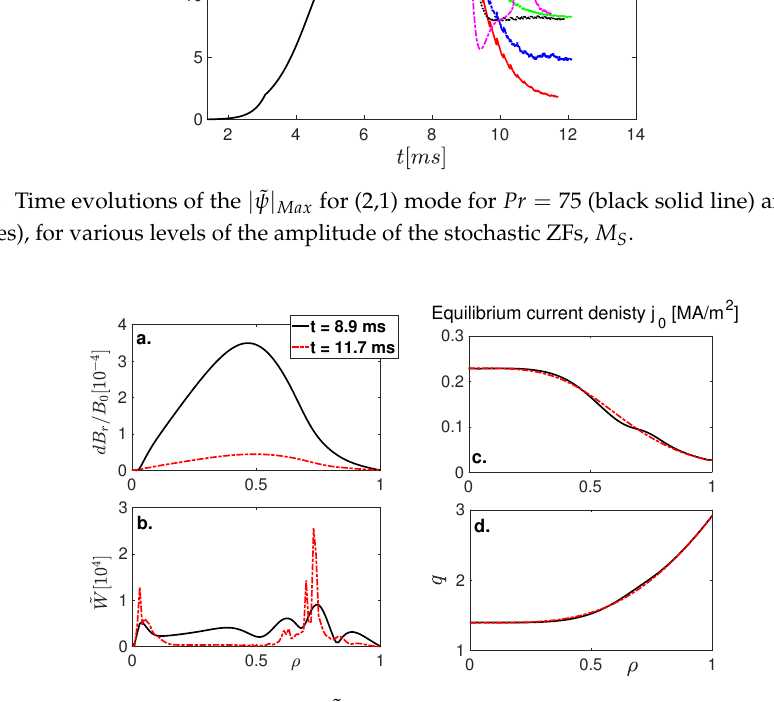
Figure 6. The profiles of the dB r / B 0 ( a ), ˜ W ( b ), equilibrium current density j 0 ( c ), and safety factor q ( d ) for the ( 2,1 ) mode case, at time t = 8.9 ms corresponding to M S = 0 (red solid lines), and t = 11.7 ms corresponding to M S = 10 − 1 (blue dotted lines).